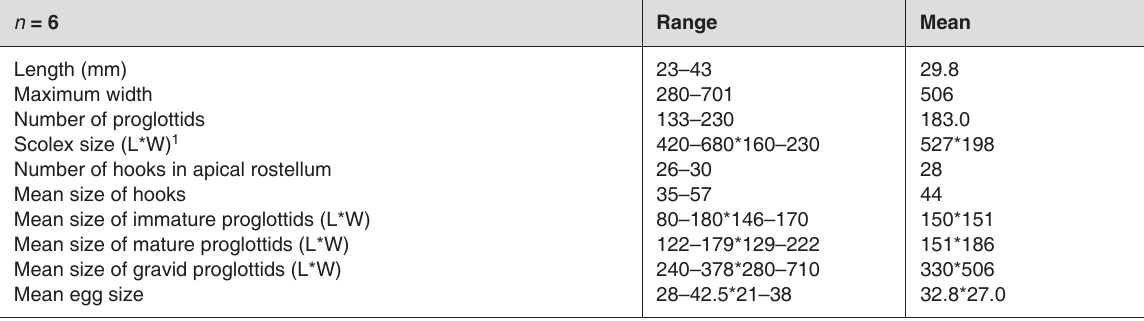
Mid-dorsal muscles between dorsal fin and lateral line